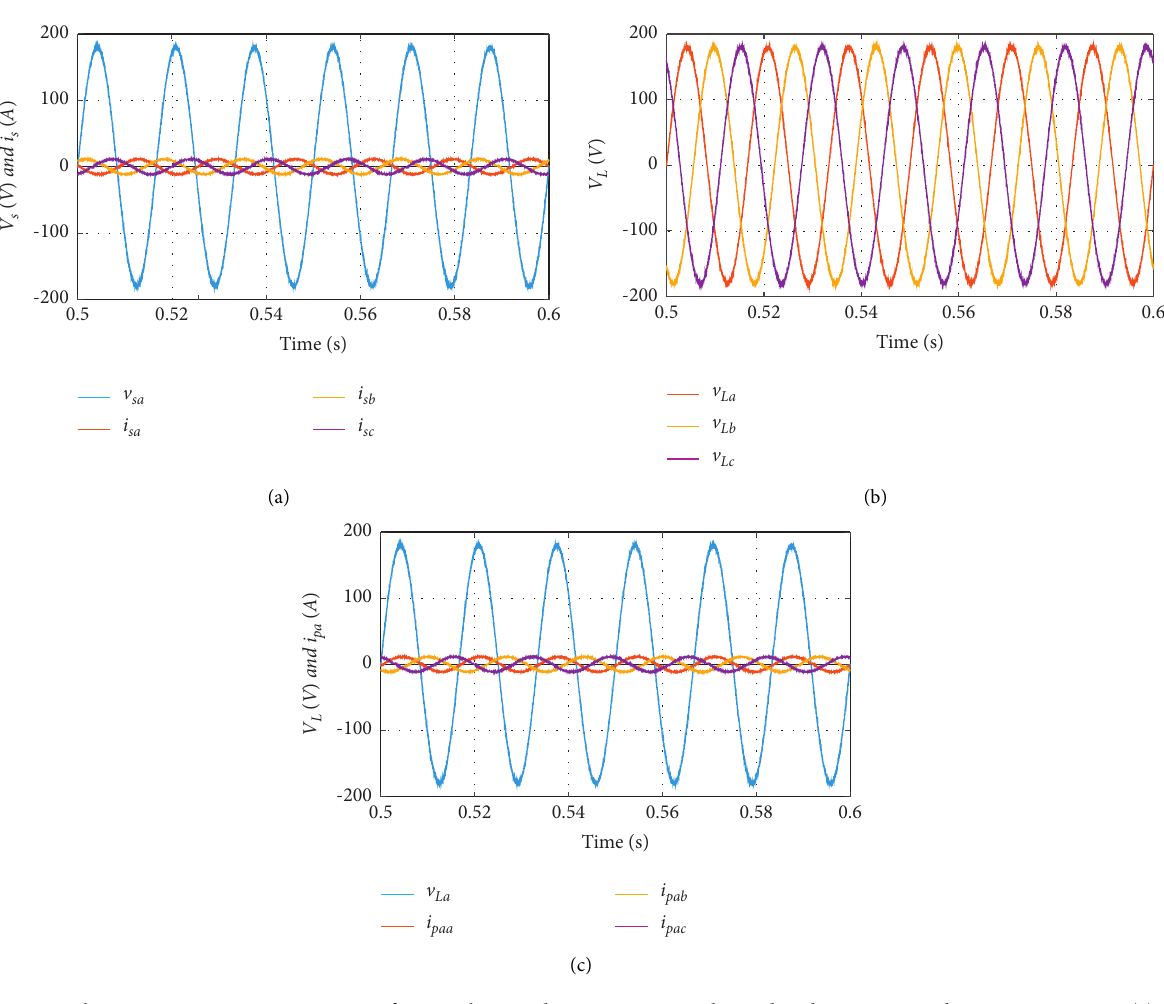
� 0 W and P � 3500W. (a) Grid L wind − pv